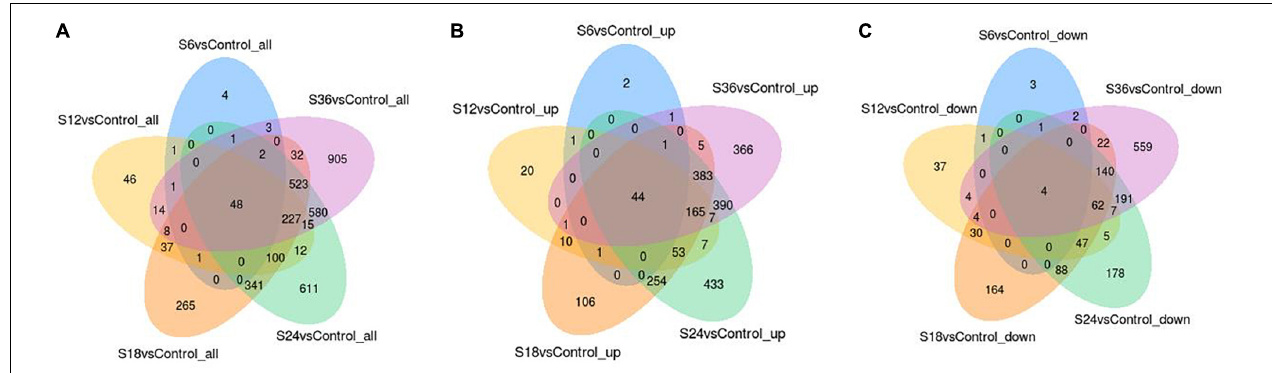
FIGURE 2 | Common genes belonging to DEGs in five comparison groups. (A) A total of 48 DEGs were commonly expressed in the five comparison groups. (B) 44 Up-regulated DEGs were commonly expressed in the five comparison groups. (C) A total of four down-regulated DEGs were commonly expressed in the five comparison